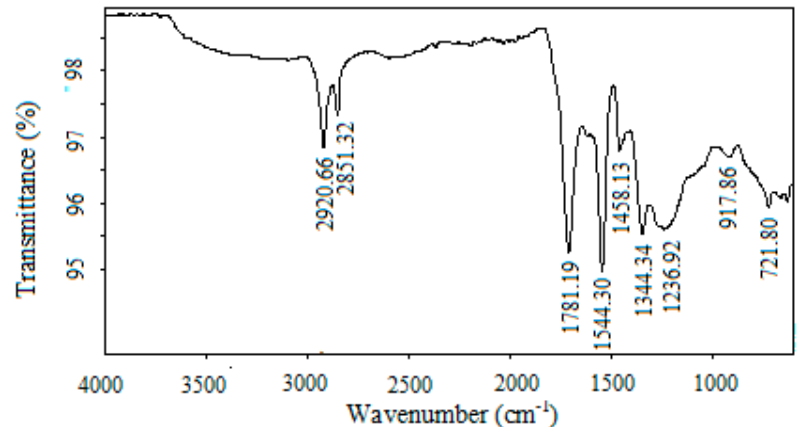
Figure 6. FTIR spectrum nano-activated carbon after dye